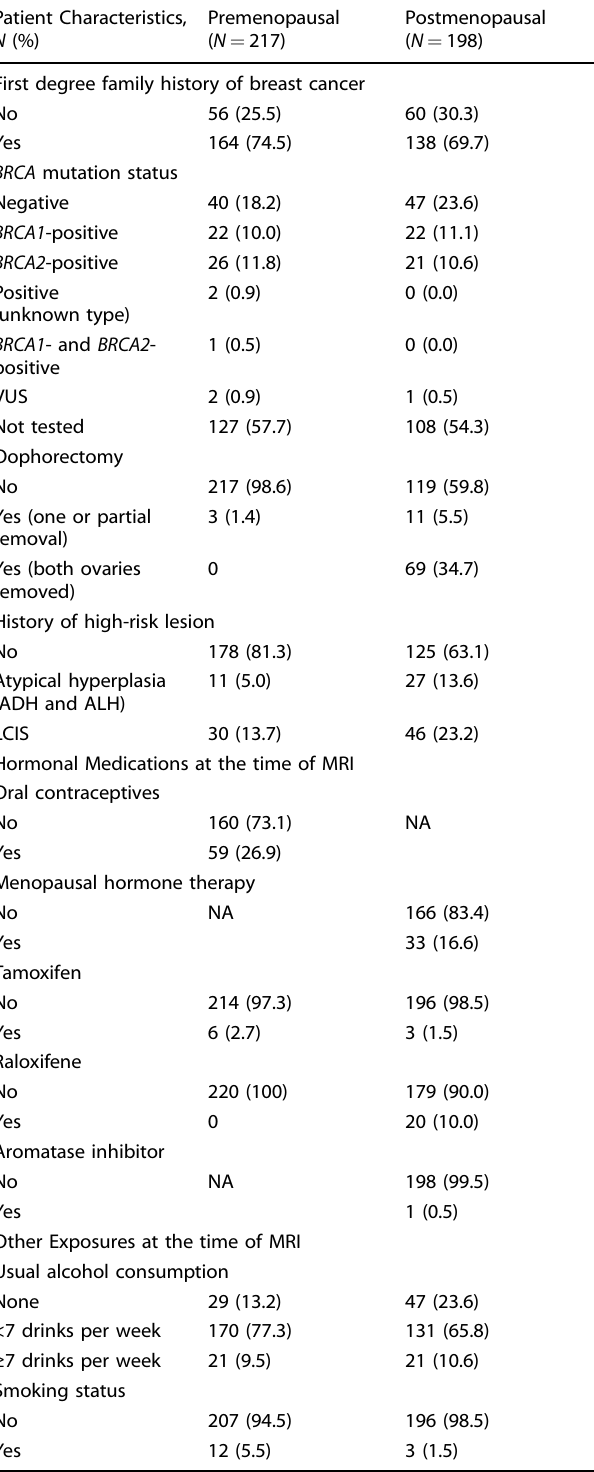
Table 3. Distribution of breast cancer risk factors by menopausal status at the time of MRI.